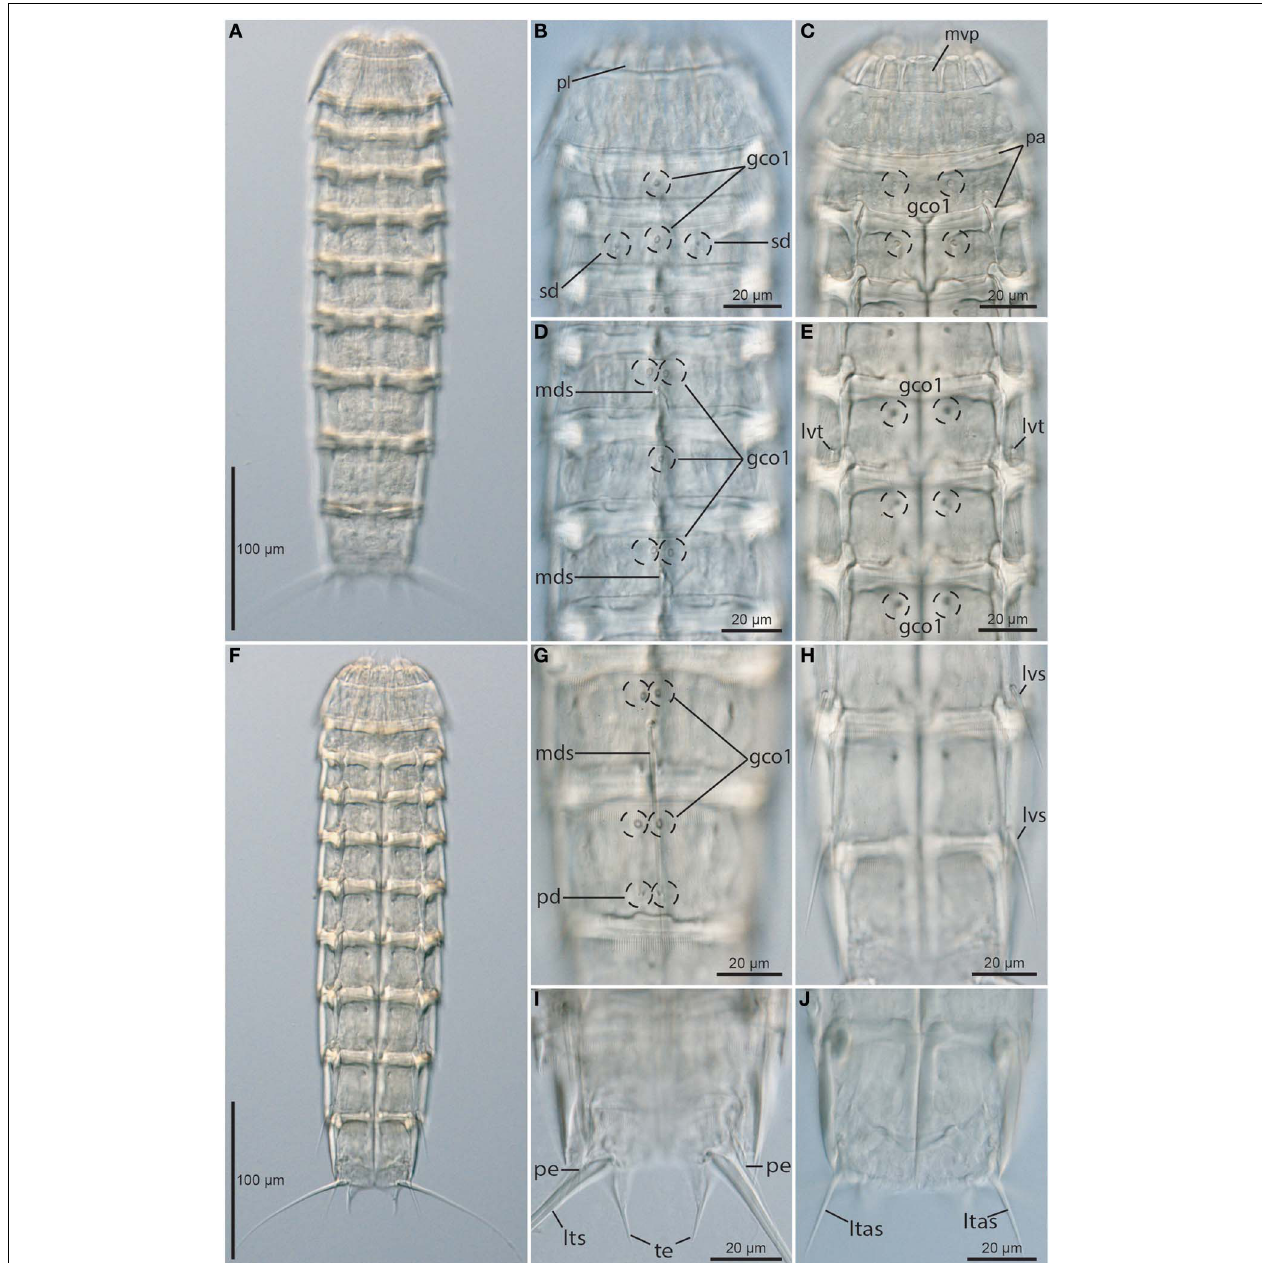
FIGURE 7 | Light micrographs showing overviews and details of trunk morphology in Echinoderes skipperae sp. nov. (A–H) and (J) female holotype (KIN-730); (I) male paratype (KIN-737). (A) Dorsal overview. (B) Neck and segments 1 to 3, dorsal view. (C) Neck and segments 1 to 3, ventral view. (D) Segments 4 to 6, dorsal view. (E) Segments 4 to 6, ventral view. (F) Ventral overview. (G) Segments 8 to 9, dorsal view. (H) Segments 8 to 10, ventral view. (I) Segments